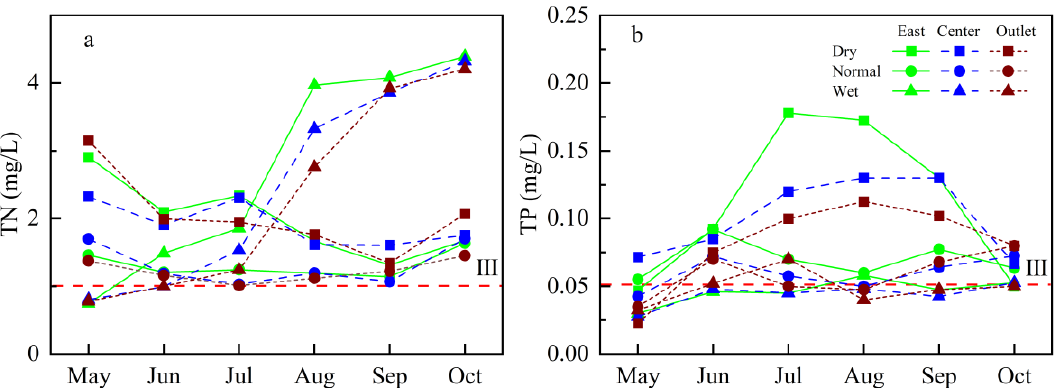
Figure 5. Monthly average TN ( a ) and TP ( b ) concentration changes in the Yuqiao Reservoir in high flow seasons from 2019 to 2021. The red dashed line represents the Grade III for lake or reservoir based on the GB3838-2002.